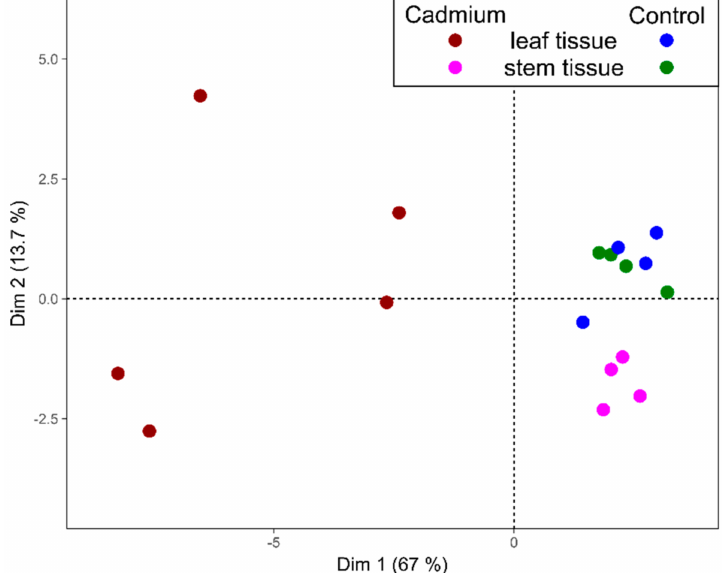
Figure 4. Principal component analysis demonstrates di ff erentiation between the leaves and stems of M. sativa after long-term Cd exposure based on their AA profile, based on values normalized to the average of the non-exposed control for each organ separately. Dim 1 captures 67% of the variance, and Dim 2 captures 13.7% of the